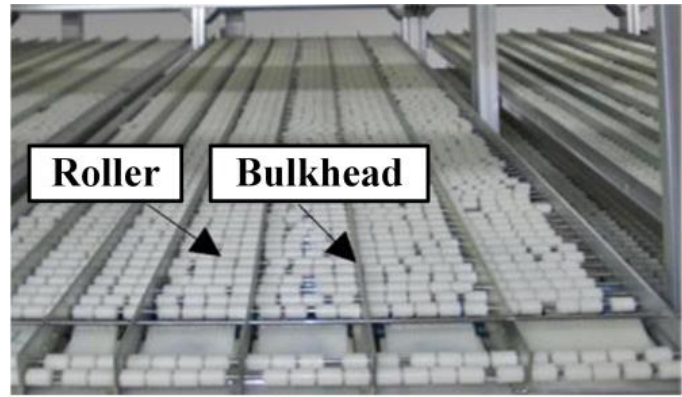
Figure 2. U-shaped storage position and medicine storage tank.